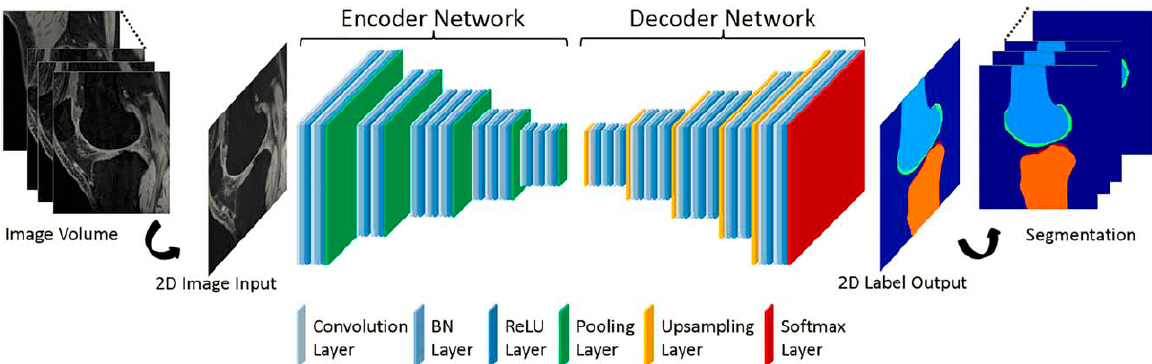
Figure 12. The SegNet CNN architecture is depicted in this diagram. SegNet is made up of two networks: an encoder and a decoder. This network’s final output is high-resolution pixel-by-pixel tissue categorization [83].